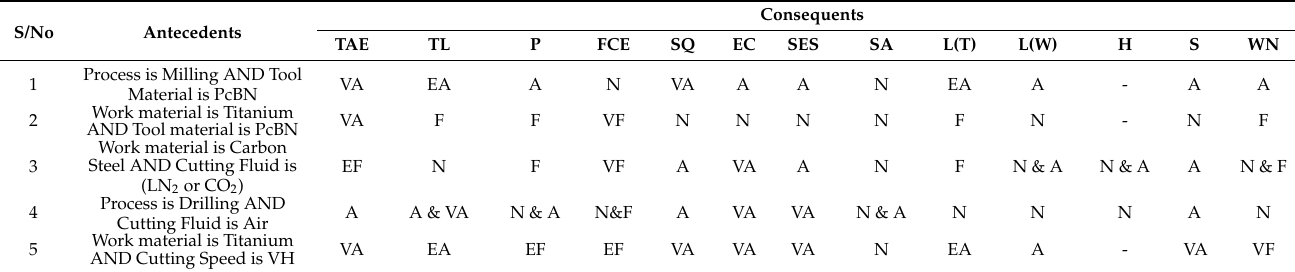
Table 3. The “High-Priority” Fuzzy Rules